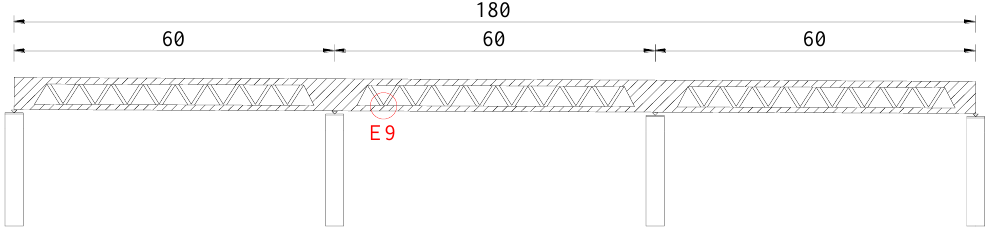
Figure 5. Layout of a steel–concrete composite continuous truss bridge (unit: m).